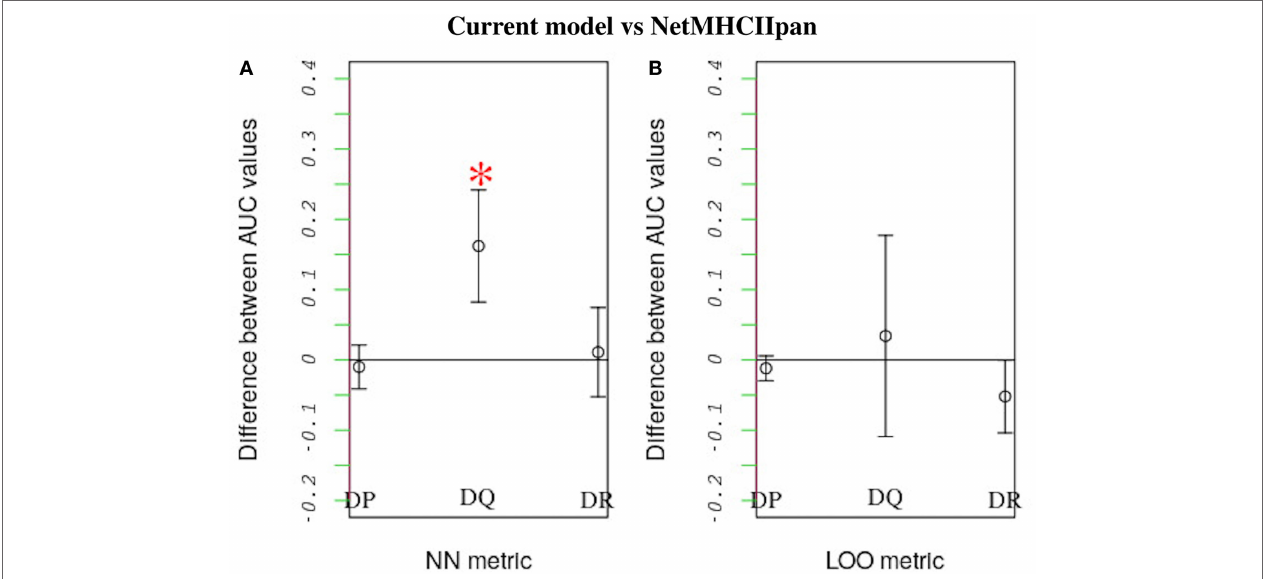
FIGURE 6 | Performance comparison between our model and NetMHCIIpan. Each model was used to predict the probability of peptide binding to query alleles belonging to each of three HLA loci (i.e., HLA-DP, HLA-DQ, and HLA-DR) after training it using peptide-binding data for a different allele. The allele that was most similar to the query allele was used for training. As in previous work (18), similarity between HLA alleles was defined based on two metrics: nearest neighbor (NN) and leave-one-out (LOO). See the text for definitions of these metrics. For each query allele, we measured each model’s predictive performance (accounting for both sensitivity and specificity) by calculating an AUC value. The higher the AUC value the better the predictive performance. The plot shows the average difference between the AUC values for alleles belonging to the same locus obtained using our model vs. the corresponding values obtained using NetMHCIIpan, when similarity is defined based on either (A) the NN or (B) the LOO metric. Error bars denote SDs. Strikingly, our model performs better than NetMHCIIpan when predicting peptide binding to HLA-DQ using the NN metric (p-value = 0.015). For all other cases, both models have equivalent performance.